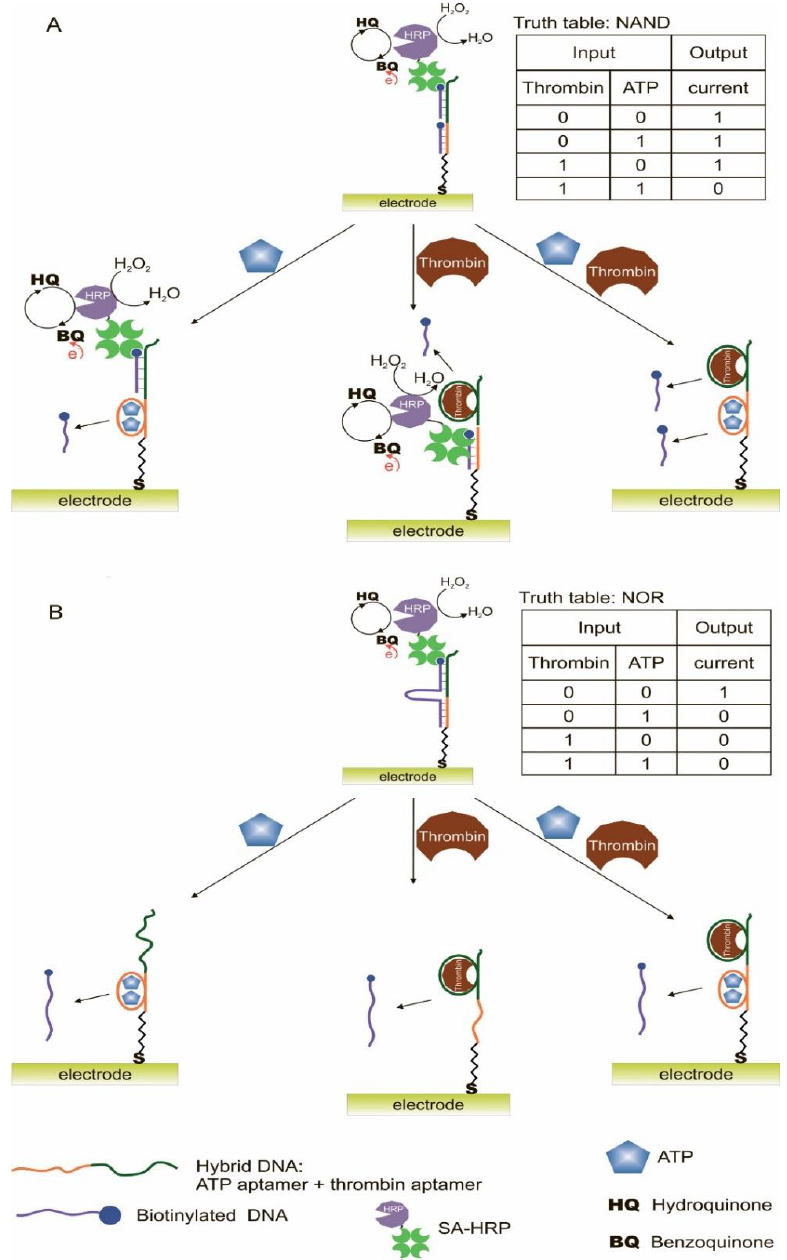
Figure 14. ( A )—Logic gate NAND. ( B )—Logic gate NOR. ATP = adenosine triphosphate, SA-HRP = streptavidin-horseradish peroxidase conjugate. Adapted from Reference [133]. Copyright © 2020 Elsevier B.V.